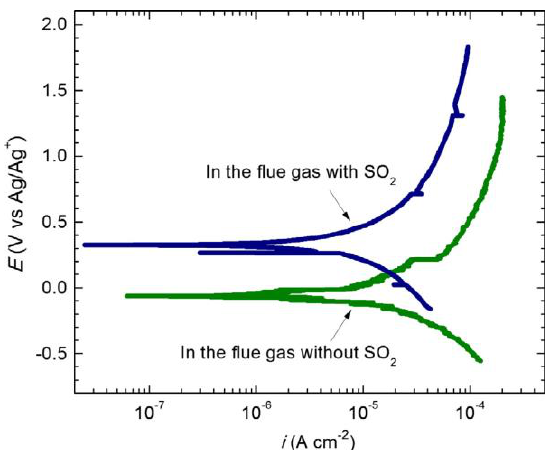
Figure 4. Comparison between Potentiodynamic Polarization (PDP) curves at different flue gas environments. Reproduced with permission from ref. [92]. Copyright 2013 Elsevier.